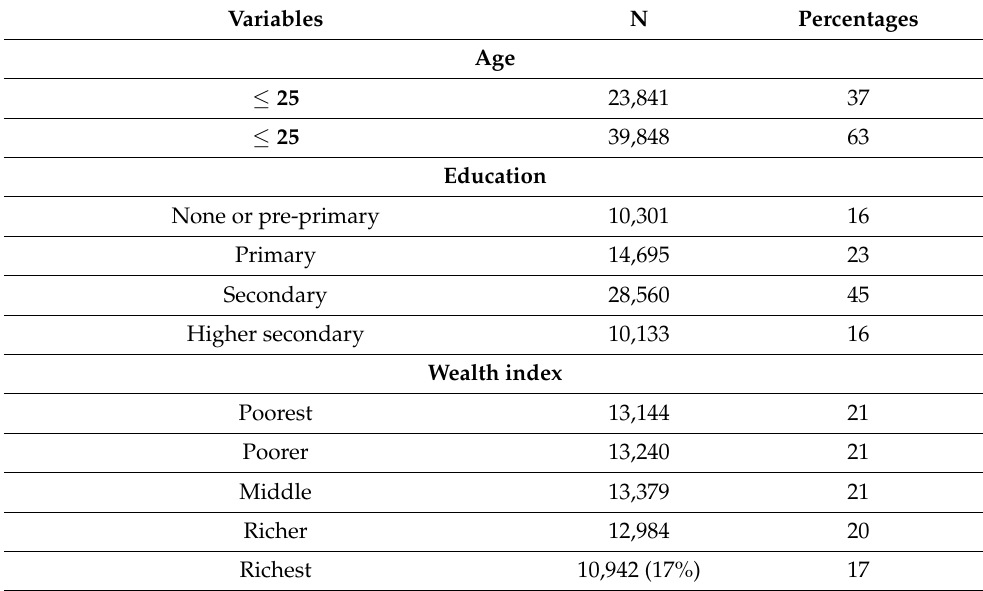
Table 1. Sociodemographic characteristics of the women sampled in the survey (N =